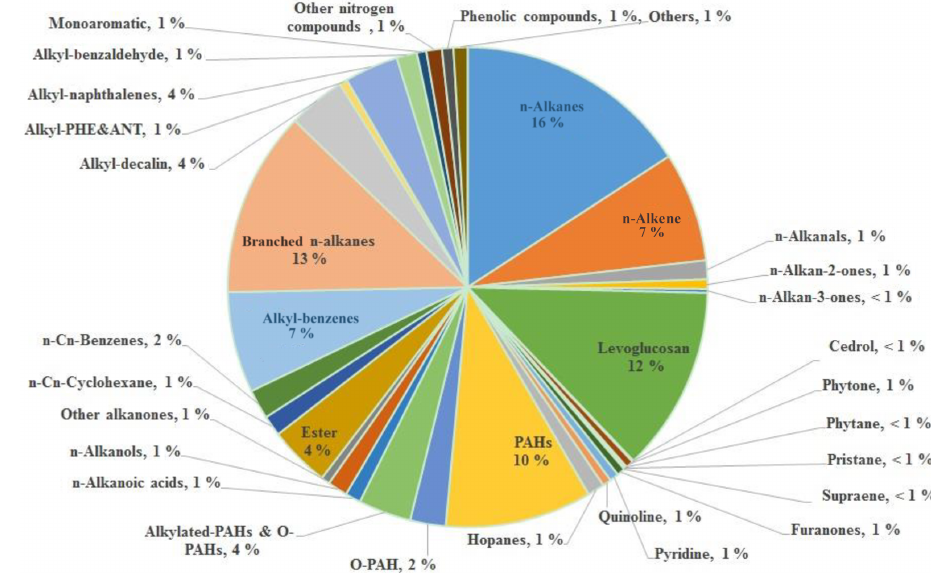
Figure 1. The percentages of the organic compound groups in the total identified organic compounds.